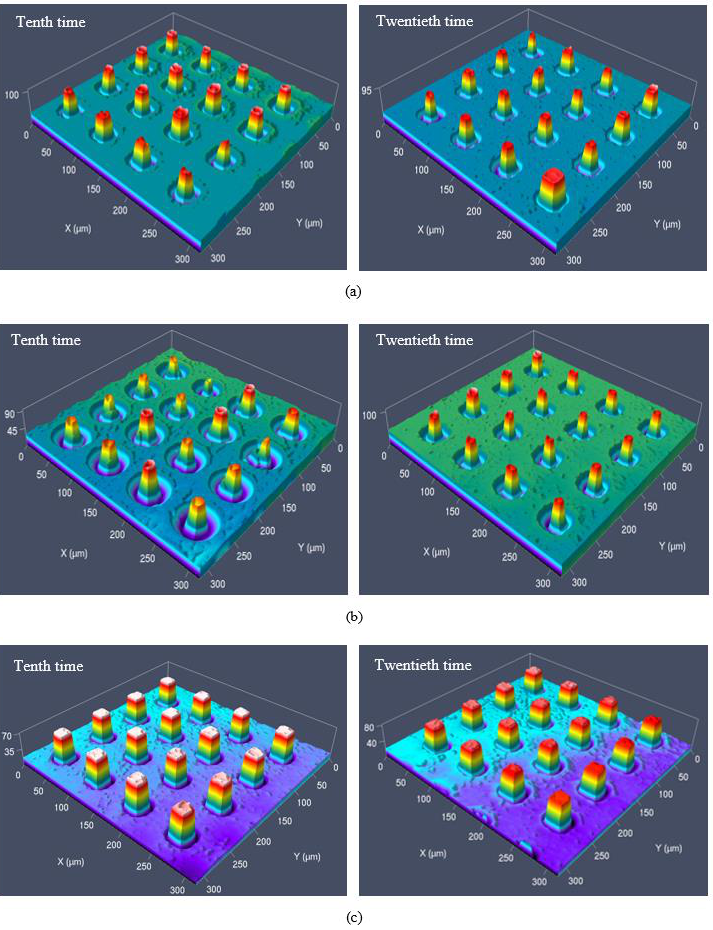
Figure 12. Morphology of local microstructure with demolding cycles: ( a ) DT; ( b ) DDT; ( c ) PFDT .